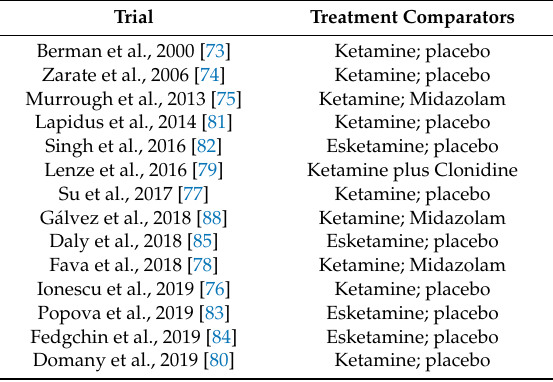
Table 8. List of Included Ketamine and Esketamine